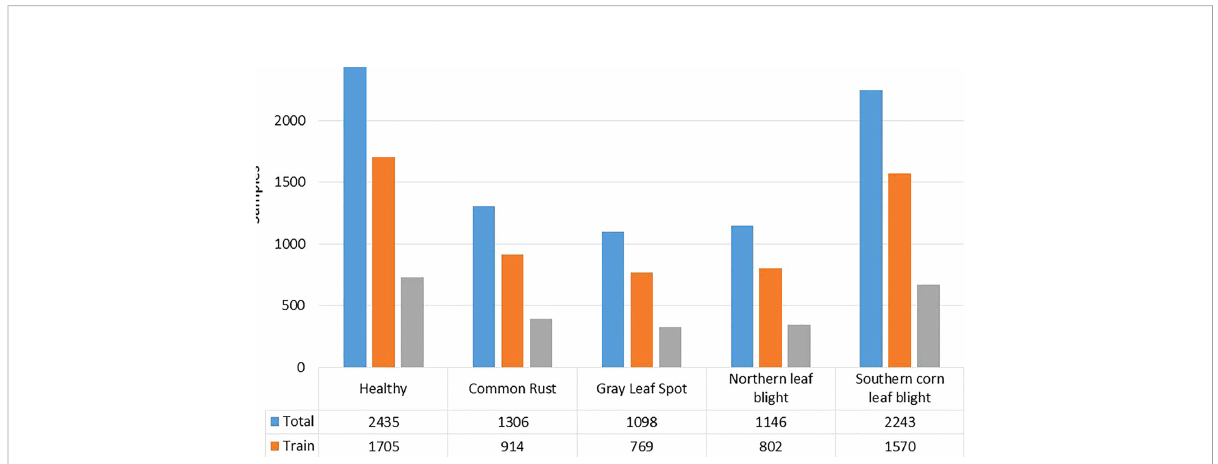
FIGURE 2 Number of class-wise samples in the maize leaf disease dataset used. To improve the diversity of the images and prevent over- fi tting problems during training, data augmentation methods such as random angle rotation, fl ipping, horizontal or vertical translation, scale alteration, and color jittering were applied. With this approach, there were at least 2500 samples in each group. The images were resized to a dimension of 240 × 240 pixels. Figure 3 displays some instances of augmented images.